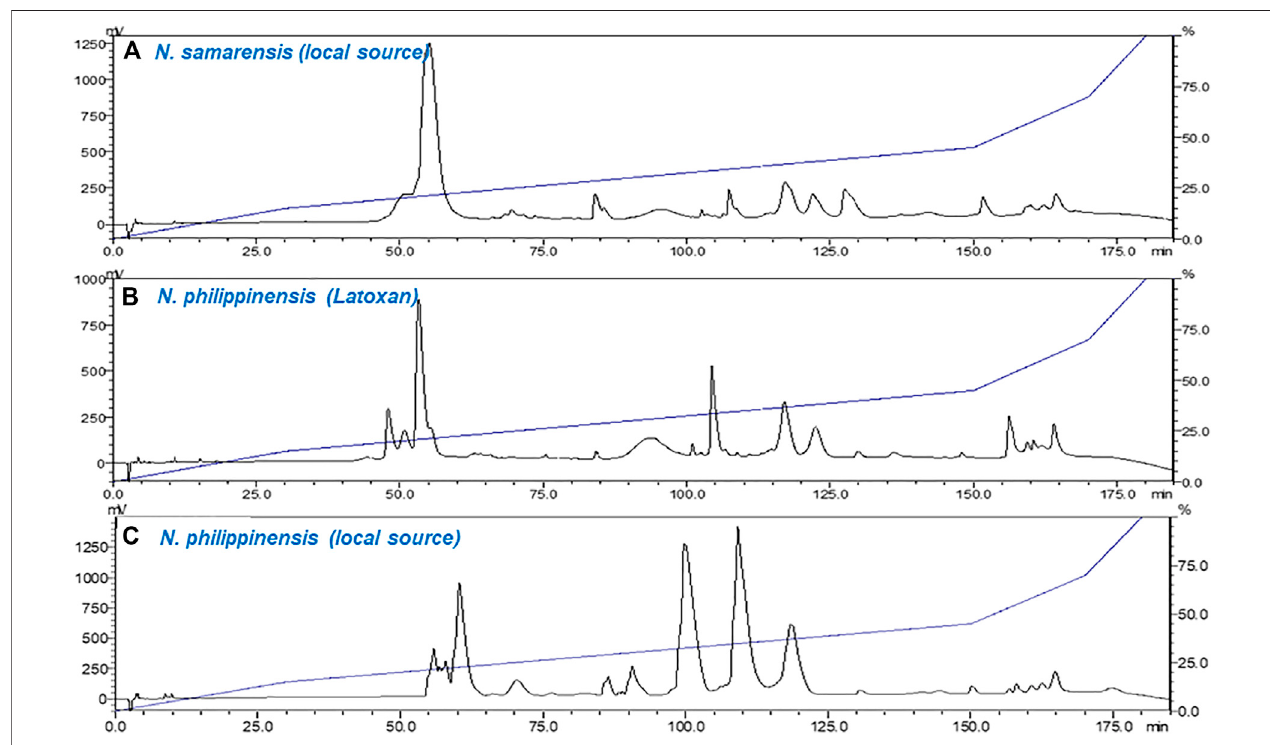
FIGURE 3 | Chromatograms of crude venom samples fractionated using C 18 reverse-phase high-performance liquid chromatography (RP-HPLC). (A) Naja samarensis (localsource); (B) Najaphilippinensis (captivesource from Latoxan); and (C) Naja philippinensis (local source). Reddottedlines highlight theelutionbetween 80 and 140